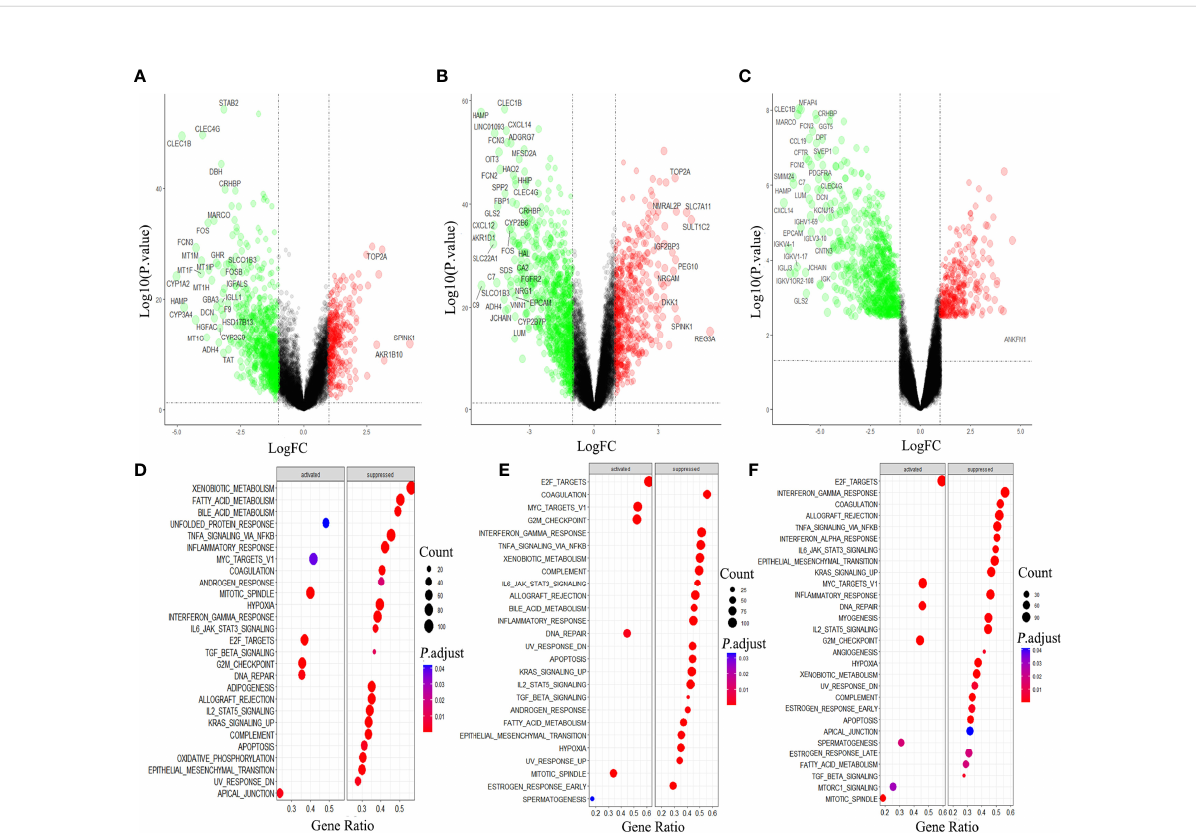
FIGURE 1 Differential gene analysis and GSEA analysis in hepatocellular carcinoma (HCC). Gene expression and GSEA analysis of HCC (A, D) , HBV-HCC (B, E) and HCV-HCC (C, F) by using R